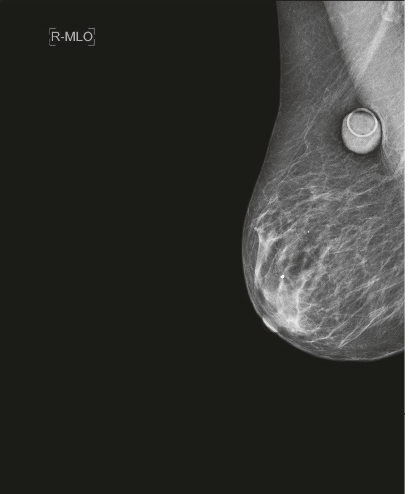
Figure 1: Mammogram (right mediolateral oblique view) confirm- ing a 25 mm, well-circumscribed nodule within the substance of the breast. This lesion had been previously documented and was slowly enlarging in size over several